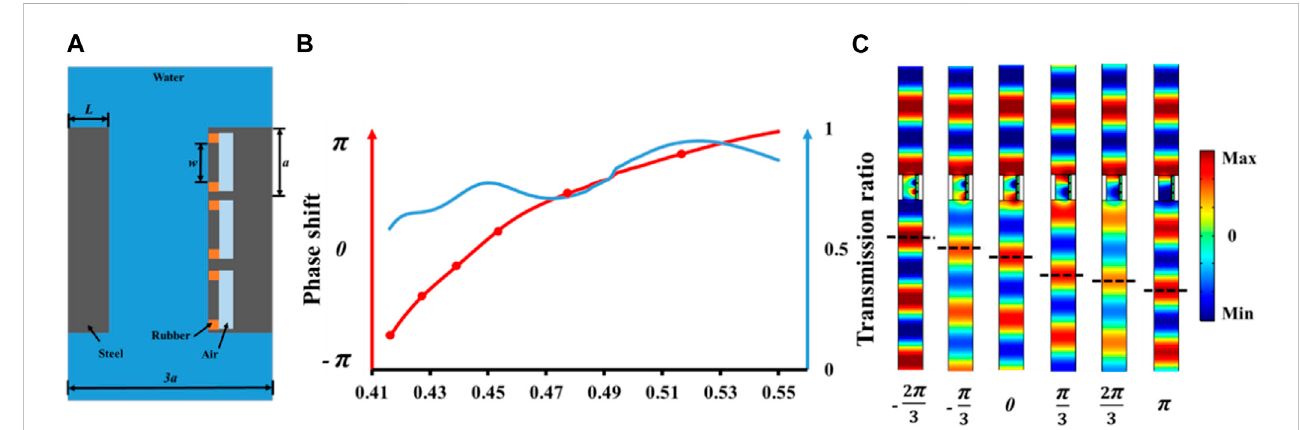
FIGURE 1 One metasurface unit: (A) the material and structure, (B) phase shift and amplitude transmission ratio as a function of ratio r for one unit, (C) normalized simulated pressure fi eld of individual units with phase shift increase of π /3 for the r denoted by red points in (B)